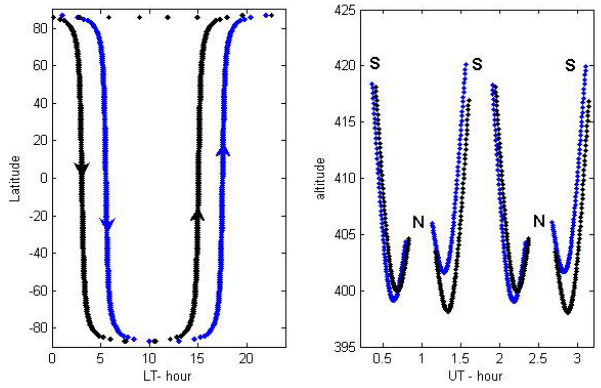
Fig. 1. Left panel: latitude – local time coverage of the data on 2 May (black diamonds) and 29 May (blue diamonds); the direction of the satellite motion along its orbit is shown by the arrows. Right panel: altitude of the 50N to 50S segments of the two first orbits of 2 and 29 May; the N and S letters refer to the 50N and 50S ends of the orbit segments,